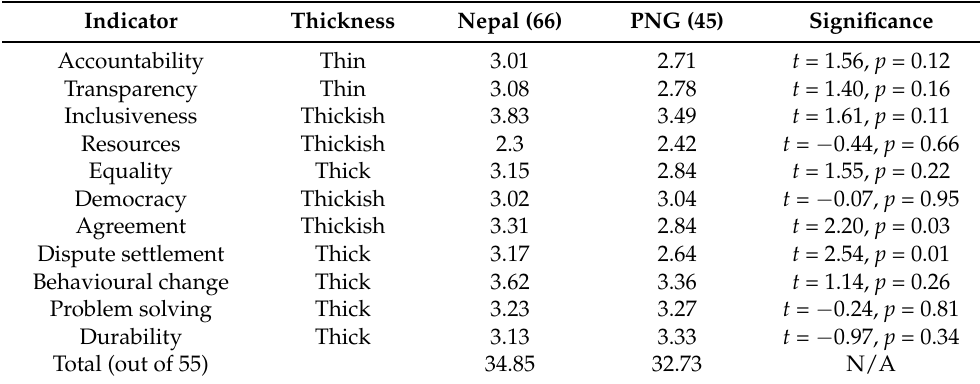
Table 3. Nepalese (2011) and PNG (2015) respondents’ online survey rating of REDD+. Indicator Thickness Nepal (66) PNG (45) Significance Accountability